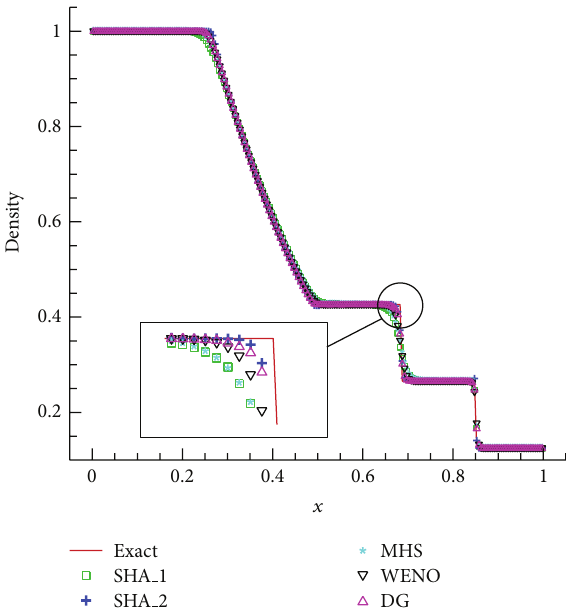
Figure 15: Pressure comparison of schemes at time 0.2 units for Sod’s tube